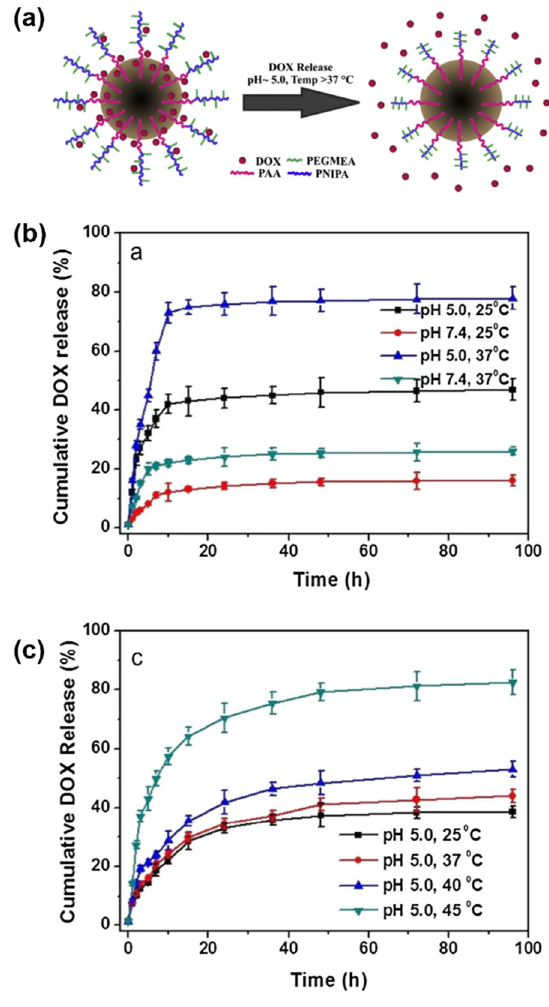
Figure 27. ( a ) Schematic representation of a therapeutic strategy combining LCST-modified thermoresponsive and pH-responsive polymer properties with IONPs. ( b ) DOX release profile from P(NIPAm) 97 -b-(tBA) 51 -DOX-MNPs under different conditions and from ( c ) [P(NIPAm) 85 -r- (PEGMEA) 15 ]-b-(PtBA) 51 -DOX-MNPs at pH 5.0 at different temperatures. Reproduced with permis- sion from reference [97]. Copyright 2016 Elsevier.